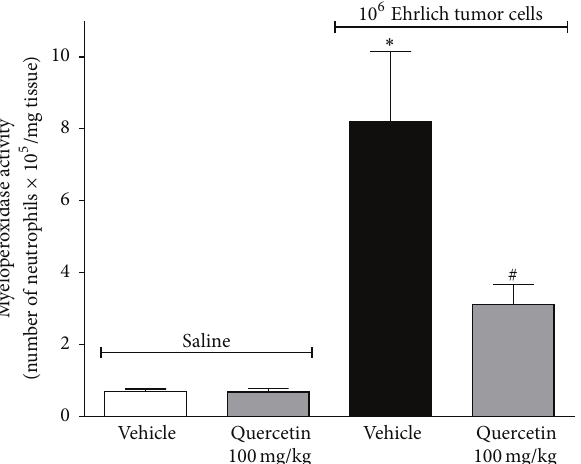
Figure 4: Quercetin inhibits neutrophil recruitment induced by Ehrlich tumor cells. Mice were treated i.p. with quercetin (100mg/kg, 2% DMSO diluted in saline) or vehicle (2% DMSO) 10 min after the injection of Ehrlich tumor cell (1 × 10 6 /25 𝜇 L) or saline (25 𝜇 L). The neutrophil recruitment was evaluated in samples of paw skin collected after 12 days of treatment using the myeloperoxidase (MPO) activity assay. Data are presented as means ± SEM of six mice per group per experiment and representative of two separated experiments: ∗ 𝑝 < 0.05 compared to the saline group and # 𝑝 < 0.05 compared to the tumor group. One-way ANOVA followed by Tukey’s